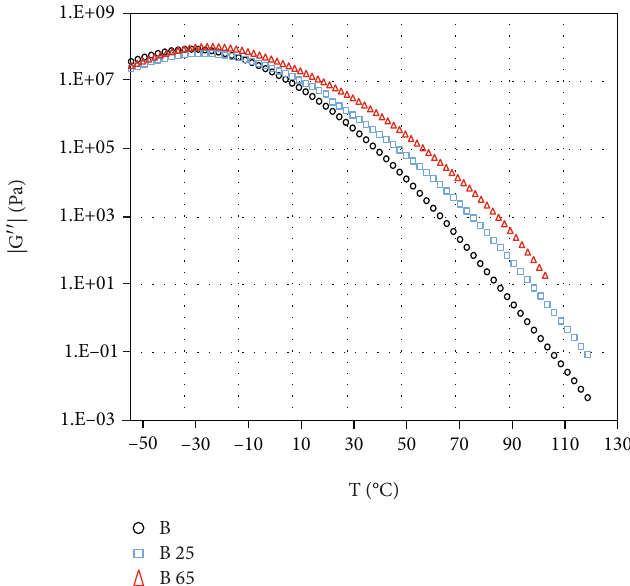
Figure 5: Loss modulus as a function of temperature after transformation ω ⟶ T , as in Figure 4.